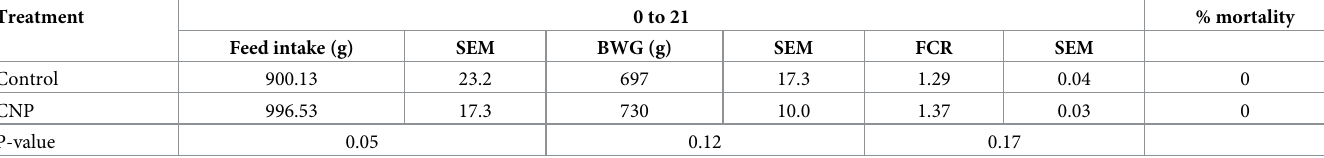
Table 2. Production performance of chickens vaccinated with in-ovo CNP vaccine. Treatment